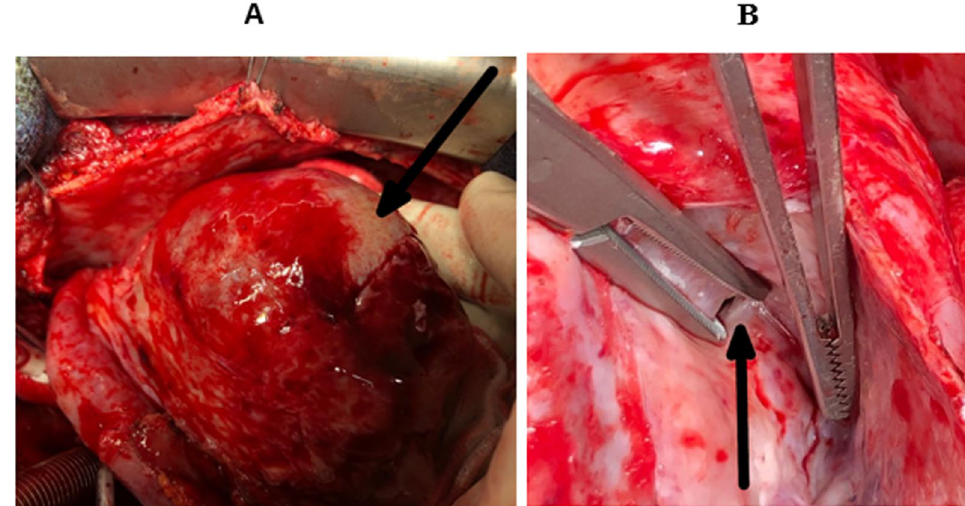
Fig. 3 Intraoperative view showing the pseudoaneurysm of the left ventricular free wall. a After installation of the CPB and exposure of the pseudoaneurysm, the aneurysm sac still intact (arrow). b After opening the aneurysm sac, the neck of the pseudoaneurysm is opened using dissecting forceps (arrow)